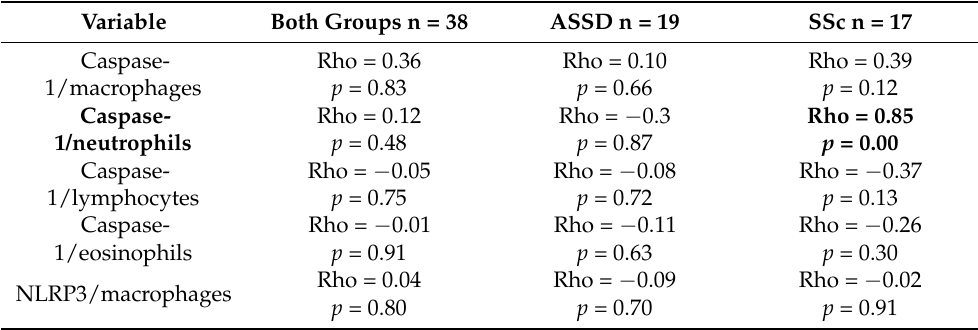
Table 5. Correlation between cells of the BAL and molecules related to the inflammasome